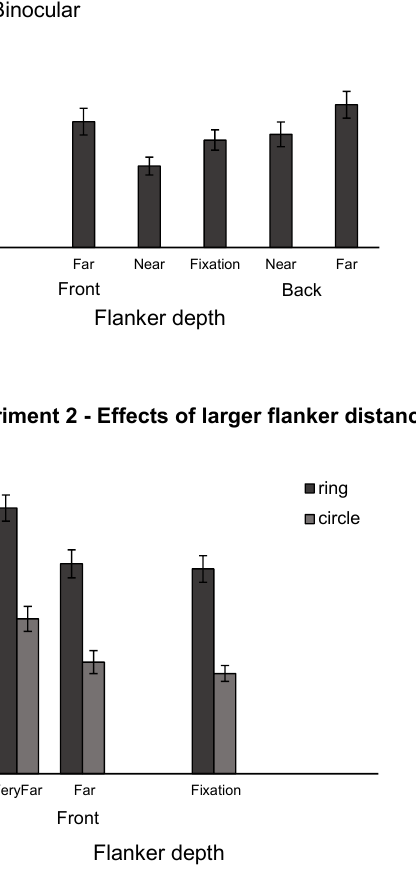
Figure 3. ( a ): Mean crowding effects and standard errors as a function of flanker depth in Experiment 1 for binocular (left) and monocular observation. ( b ): mean crowding effects and standard errors in Experiment 2 as a function of flanker depth and kinds of flankers. The x-axis of the plot is aligned to the plot above to facilitate comparison of result patterns. In both experiments, targets were presented on the fixation depth while flankers were defocused. Observer pictograms on the left side of the x-axis illustrate that data points from left to right are ordered with regard to increased distance from the observer; x-labels refer to the fixation-centered reference labelling used throughout the